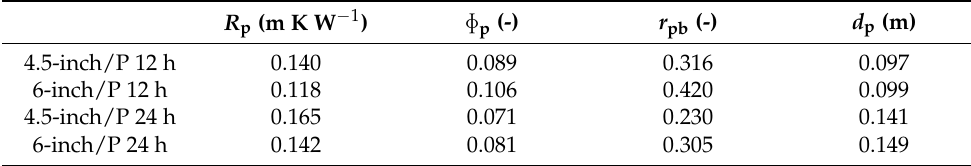
Table A1. Oscillatory parameters inferred from the validation of the analytical procedure.